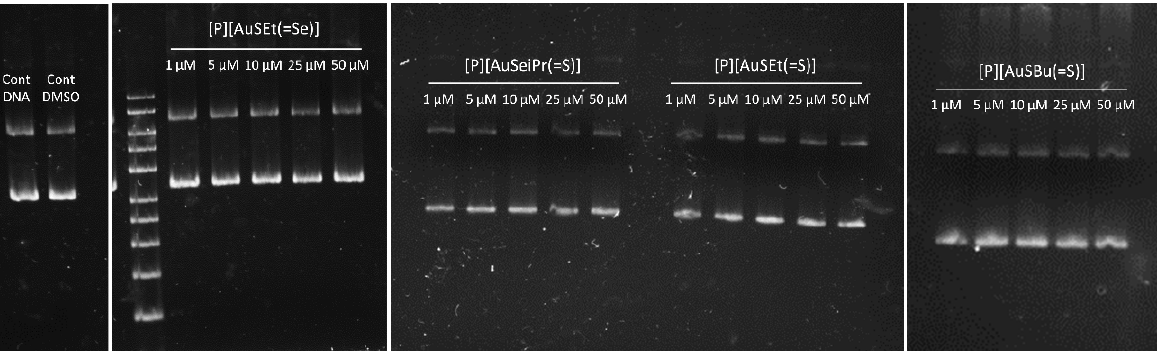
Figure 8. Assessment of the interaction between supercoiled ϕ X174 DNA and selected complexes under study ([ P ][AuSEt(=Se)], [ P ][AuSe i Pr(=S)], ([ P ][AuSEt(=S)] and [ P ][AuSBu(=S)],) after 24 h of incubation at 37 °C.